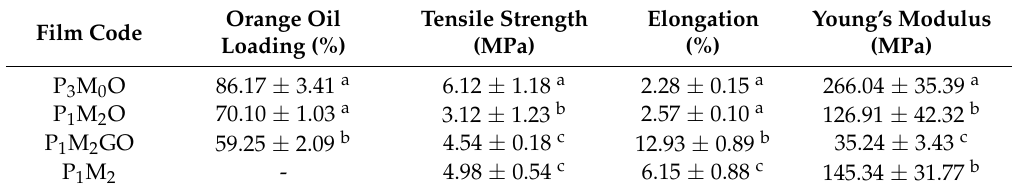
Table 3. Orange oil loading content, tensile strength, elongation, and Young’s modulus of films containing orange Table 3 . Orange oil loading content, tensile strength, elongation, and Young ’ s modulus of films containing orange oil .